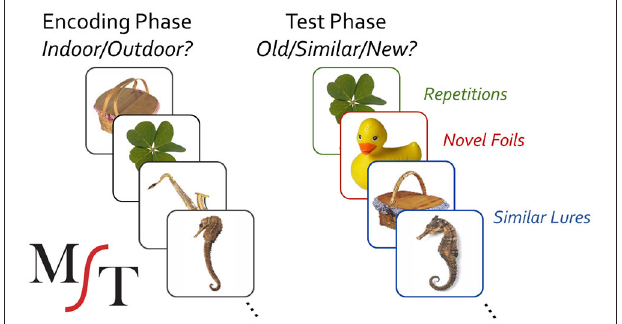
FIGURE 1 | Mnemonic similarity task; colored boxes are to illustrate conditions, but not used during the actual task